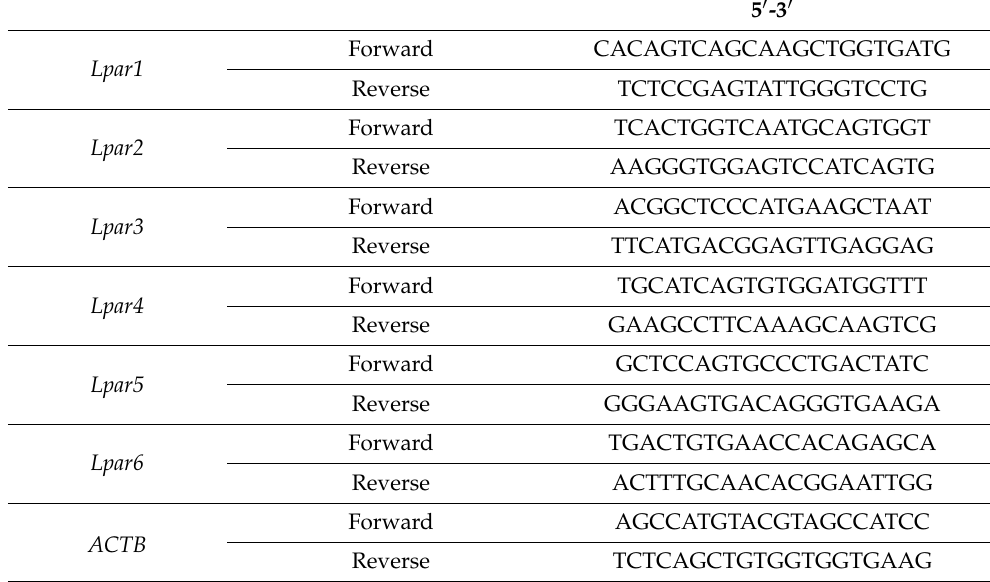
Table 1. Primers used for